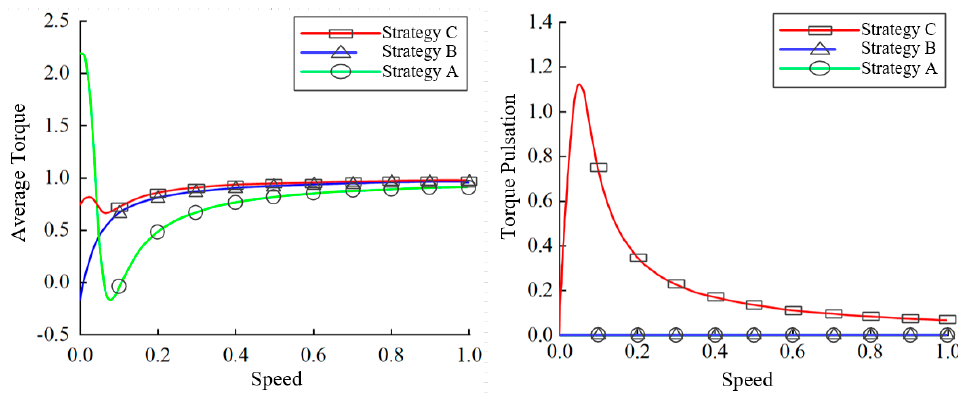
Figure 2. Performance comparison of three fault − tolerant strategies.